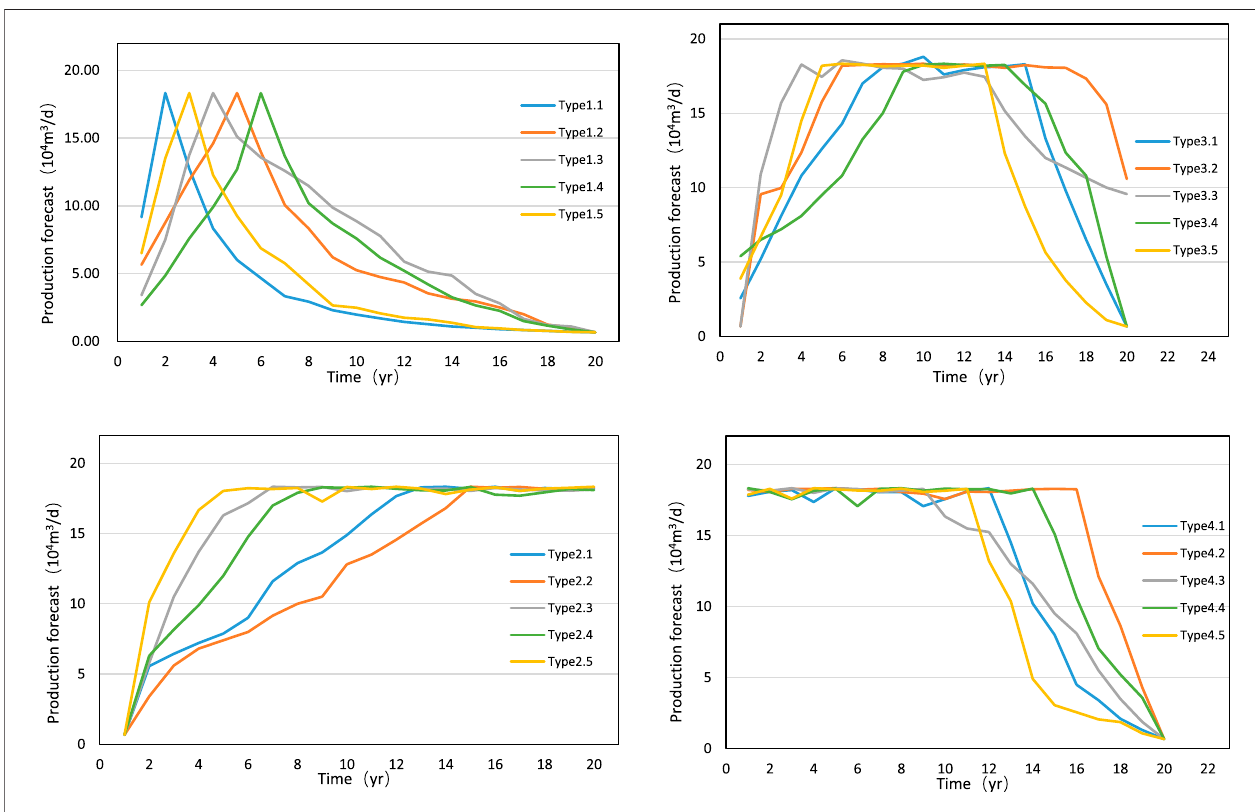
FIGURE 8 | Four types of common gas fi eld block productivity planning schemes.